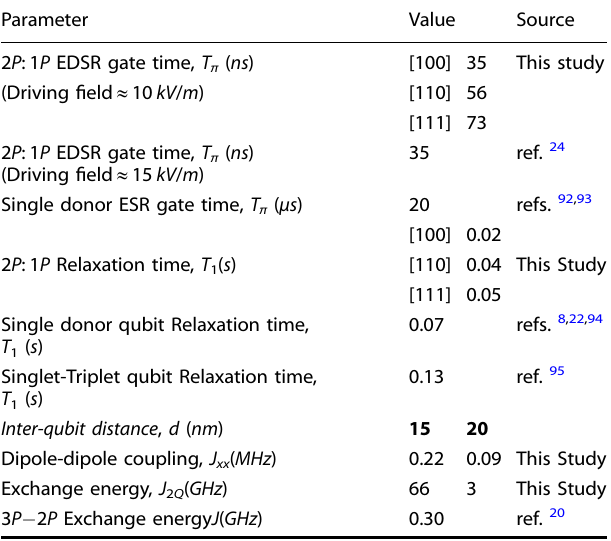
Table 3. The one qubit time scales: T π , T 1 ; and the two qubit energy scales: J 2 Q , J xx . In all calculations the external magnetic fi eld B =